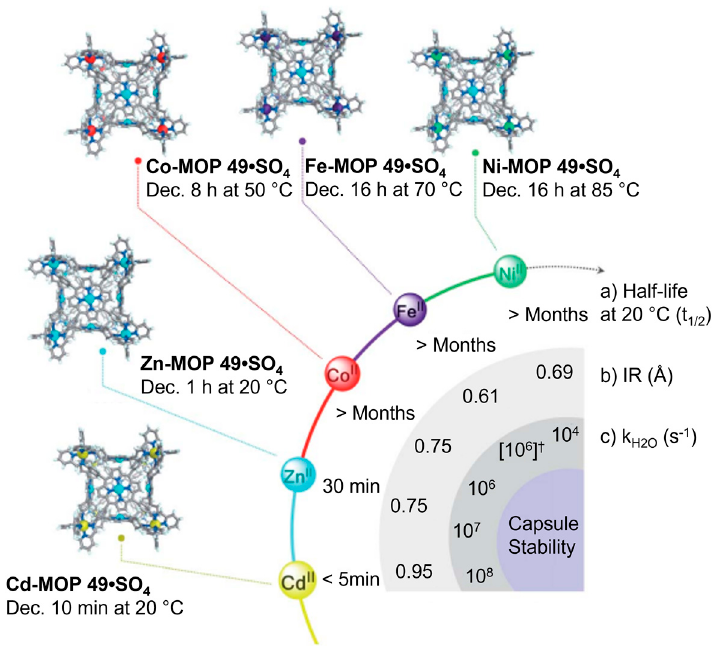
Figure 22. Relative stability of cubes MOP 49•SO 4 in water. Crystal structures (Ni-MOP 49, Fe-MOP 49, and Co-MOP 49) and MM3 models (Zn-MOP 49 and Cd-MOP 49) of cubes with their decomposition conditions are presented. (a) Half-lives (t 1/2 at 20 °C), (b) ionic radii (IR, Å) and (c) ligand-exchange rates for water ( k H2O , s − 1 ) for the different metal ions are displayed for comparison. (†) Although Fe-MOP 49 is low-spin, k H2O for high-spin Fe II is given because [Fe(H 2 O) 6 ] 2+ is high-spin. Reprinted by permission from Ref. [174]. Copyright from 2019 from Royal Society of Chemistry.